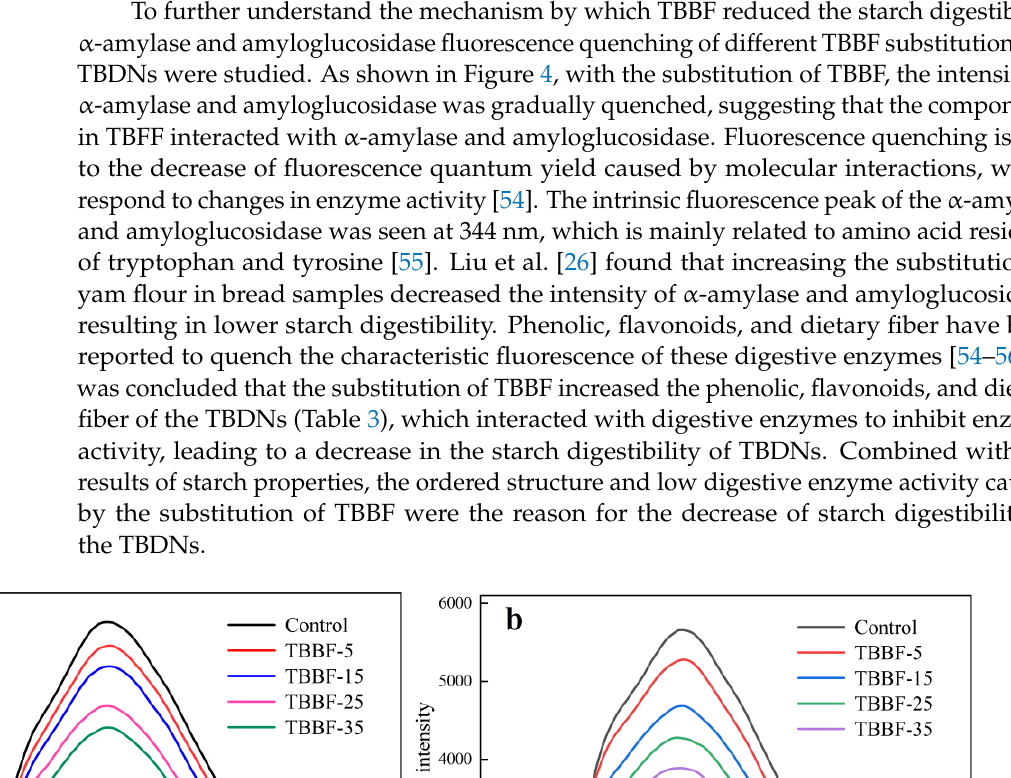
Figure 3. Fourier transform infrared spectra of Tartary buckwheat dried noodles. Control, TBBF-5, TBBF-15, TBBF-25, and TBBF-35 represent Tartary buckwheat dried noodles with 0%, 5%, 15%, 25%, and 35% substitution of Tartary buckwheat bran flour, respectively.